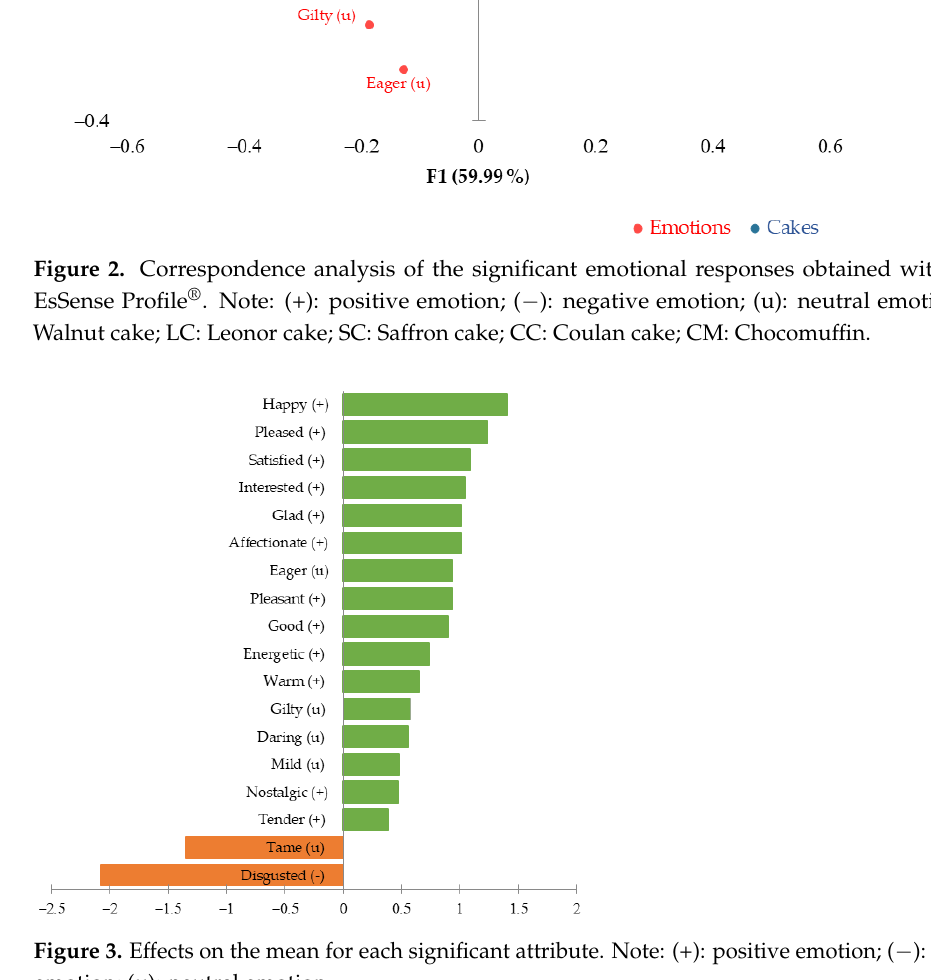
Figure 2. Correspondence analysis of the significant emotional responses obtained with CATA Es- Sense Profile ® . Note: (+): positive emotion; ( − ): negative emotion; (u): neutral emotion; WC: Walnut cake; LC: Leonor cake; SC: Saffron cake; CC: Coulan cake; CM: Chocomuffin.